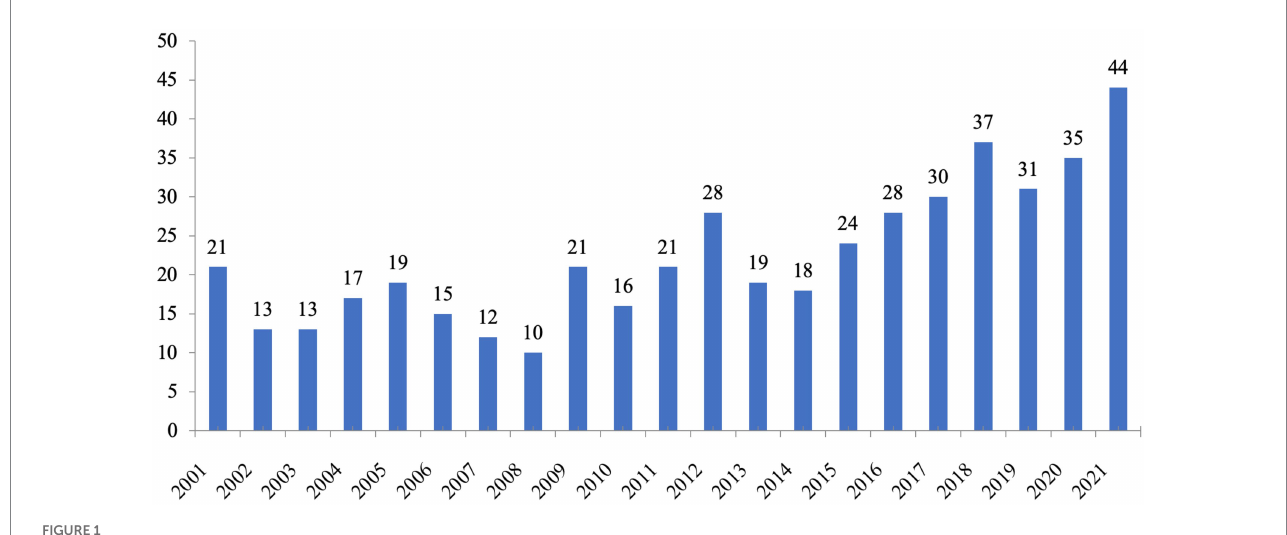
FIGURE 1 Annual publications regarding lexical inferencing in WoS.